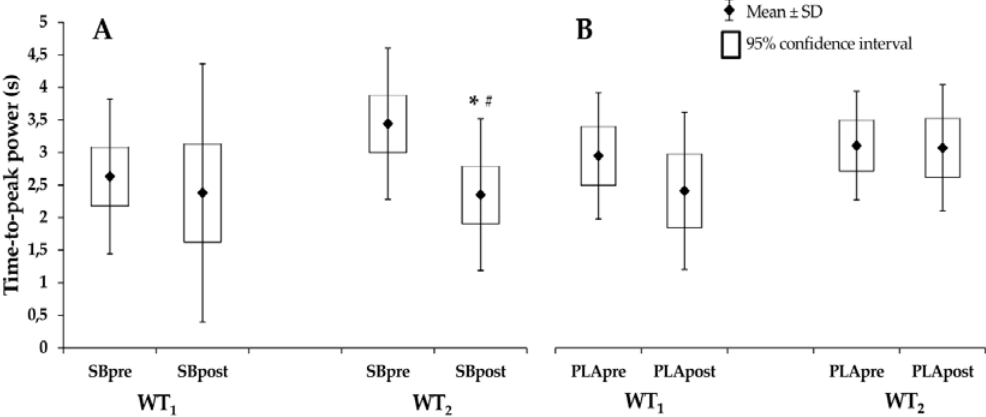
Figure 2. Time ‐ to ‐ peak power in the anaerobic Wingate test. ( A ) Before and after sodium Figure 2. Time-to-peak power in the anaerobic Wingate test. ( A ) Before and after sodium bicarbonate. bicarbonate. ( B ) Before and after placebo. Values are means ± standard deviation (and 95% ( B ) Before and after placebo. Values are means ± standard deviation (and 95% confidence intervals). confidence intervals). Abbreviations: SBpre—before sodium bicarbonate supplementation, Abbreviations: SBpre—before sodium bicarbonate supplementation, SBpost—after sodium bicarbonate SBpost—after sodium bicarbonate supplementation, PLApre—before placebo treatment, supplementation, PLApre—before placebo treatment, PLApost—after placebo treatment, WT 1 PLApost—after placebo treatment, WT 1 —the Wingate test before the dummy throw test, WT 2 —the Wingate test after the dummy throw test. * significantly different from SB PRE in the WT 2 ( p = 0.0018), # significantly different from PLA POST in the WT 2 ( p = 0.0142).